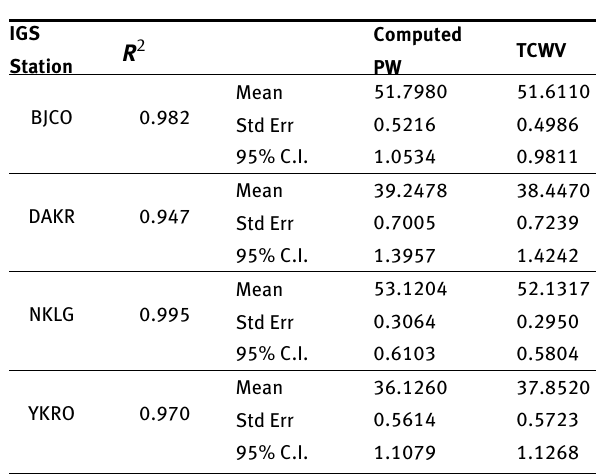
Table 3: R 2 and descriptive statistics of TCWV and computed PW for